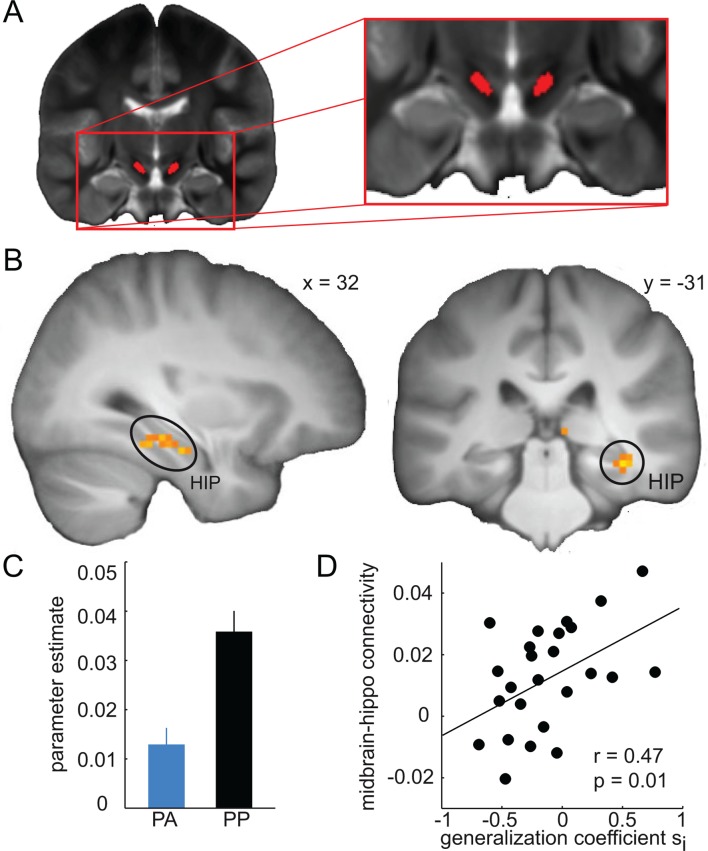
Amisulpride modulates midbrain-hippocampal connectivity.(A) Anatomical seed region in the midbrain is overlaid on a T2-weigthed image averaged across subjects. (B) Functional connectivity between the midbrain and the hippocampus during generalization test is significantly reduced in the amisulpride group (P < 0.05, FWE small volume corrected). For illustration, t-map from two-sample t-test (PP > PA) is thresholded at P < 0.001, uncorrected and overlaid on a T1-weigthed image averaged across subjects. (C) For illustration, bar plot depicting average midbrain-hippocampus connectivity in both groups. (D) Strength of midbrain-hippocampal connectivity is positively correlated with the width of the model-estimated inhibitory generalization coefficient (r = 0.47, P = 0.01) in the amisulpride group. Error bars are SEM for N = 25 (PA) and N = 21 (PP).